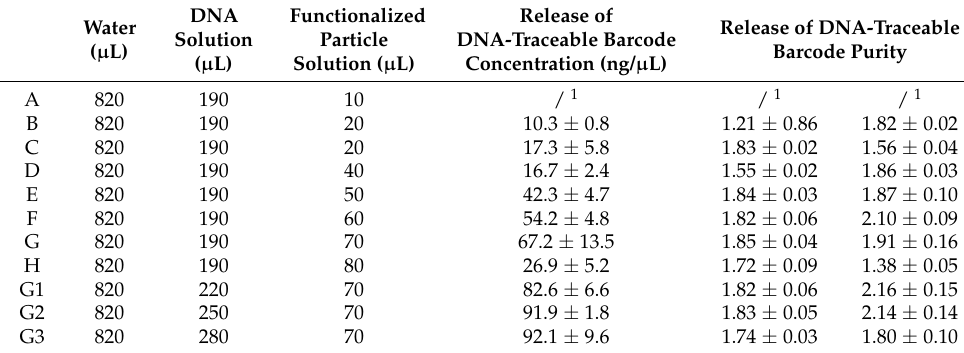
Table 2. The optimization protocols performed on the base configuration system. DNA solution at a concentration of 50 µ